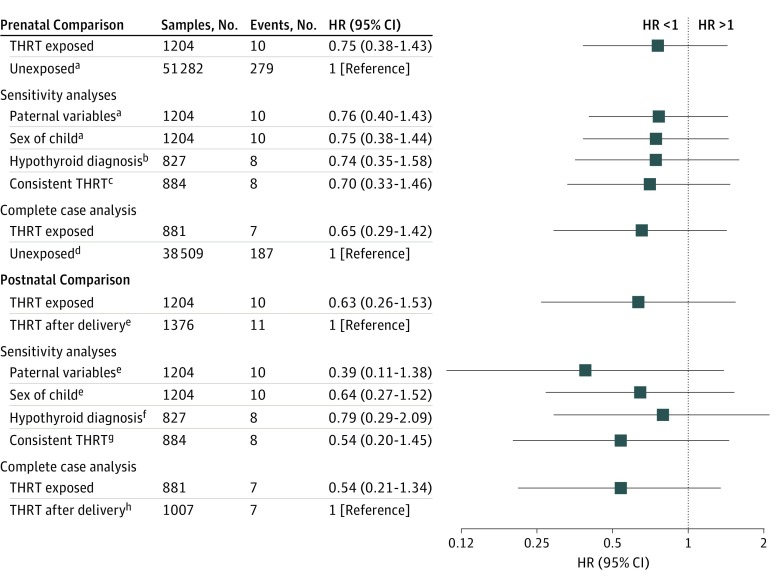
Main and Sensitivity Analyses in the Norwegian Patient Registry Study SampleHR indicates hazard ratio; THRT, thyroid hormone replacement therapy.aCrude effect estimates HR, 0.95; 95% CI, 0.55-1.62.bCrude effect estimates HR, 0.93; 95% CI, 0.51-1.69.cCrude effect estimates HR, 1.14; 95% CI, 0.49-1.56.dCrude effect estimates HR, 1.05; 95% CI, 0.64-1.71.eCrude effect estimates HR, 0.52; 95% CI, 0.22-1.23.fCrude effect estimates HR, 0.56; 95% CI, 0.22-1.42.gCrude effect estimates HR, 0.42; 95% CI, 0.15-1.14.hCrude effect estimates HR, 0.45; 95% CI, 0.16-1.28.